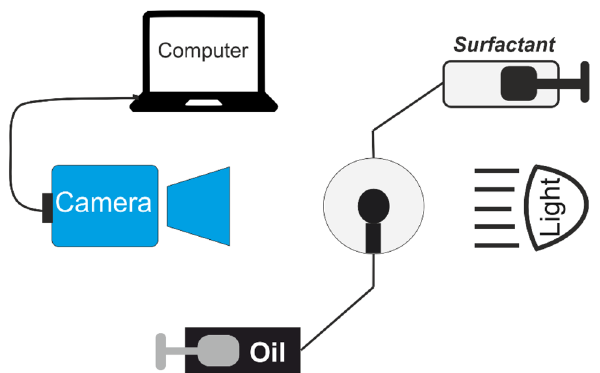
Fig. 5 Schematic representation of VIT-6000 apparatus used to meas- ure IFT and contact angle Fig. 6 Schematic representation of the theory behind the estima- tions of IFT and wettability behaviour of rock-fluid/fluid- fluid systems: a IFT shape drop and b wettability conditions (Teklu et al.